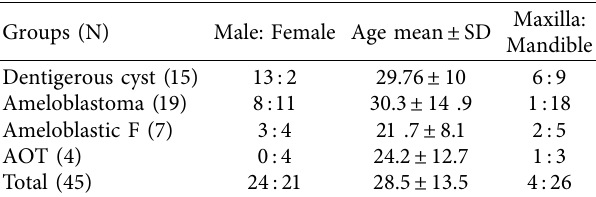
Table 1: Baseline data of all